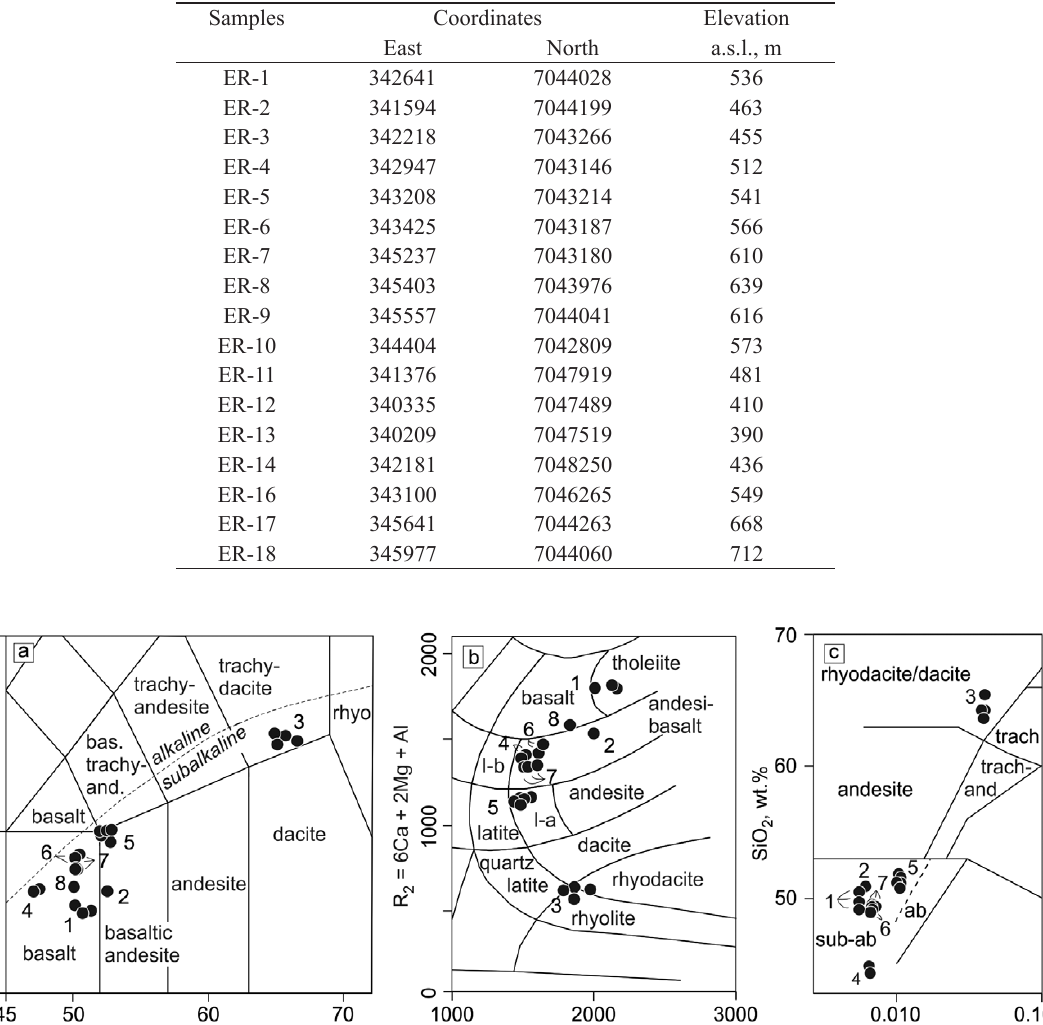
O + k O x SiO 2 2 2 x SiO (Winchester and Floyd 1977). Flow number 2 2